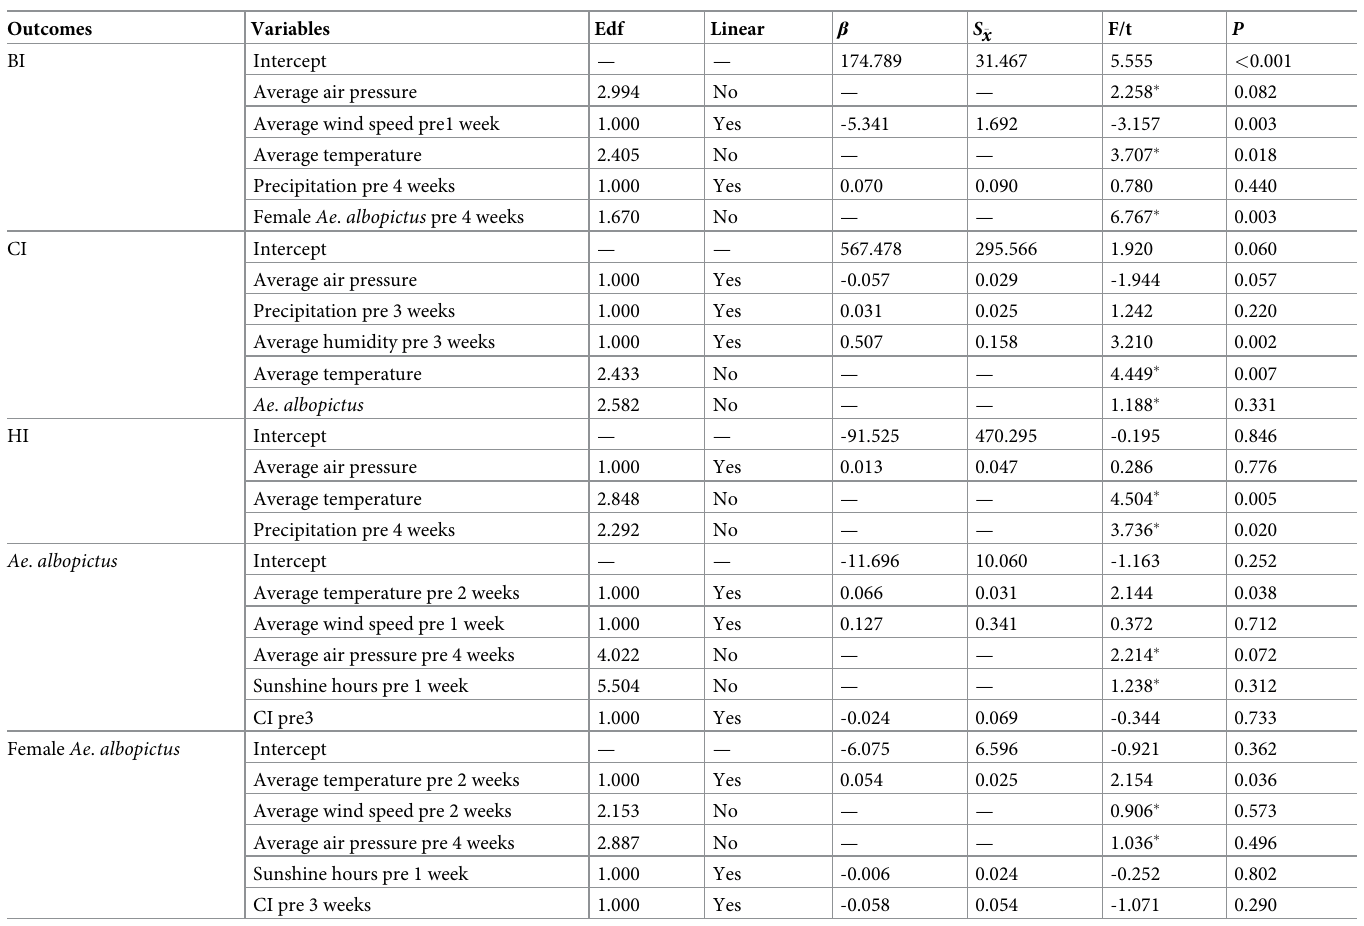
Table 3. The results of